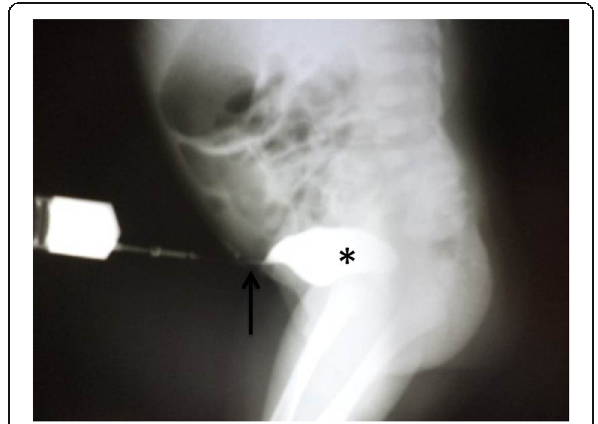
Fig. 9 Urachal fistula in an infant. Fistulogram image showing the fistulous tract (arrow) leading to the urinary bladder (*)